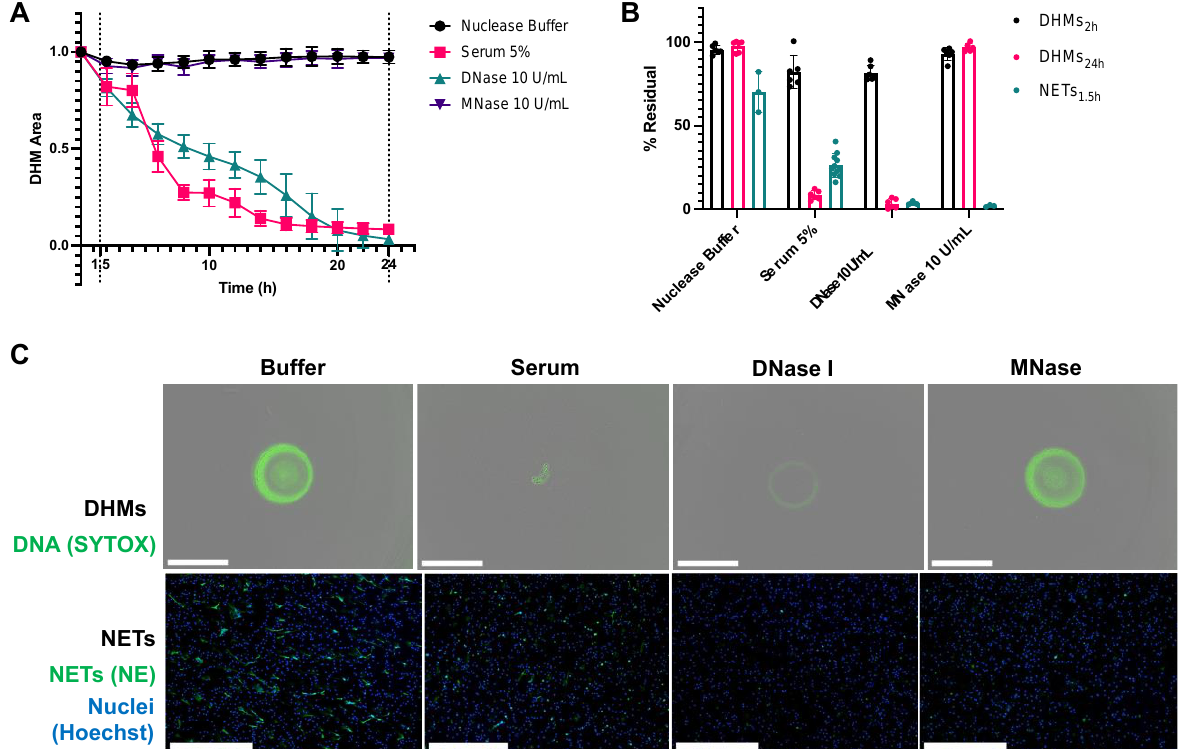
Figure 5. Differences are noted between cell-derived NETs and DHMs. ( A ) The kinetic curves of DHM degradation show that while NETs were degraded after a 1.5-h incubation, a time point marked with a dotted line, DHMs required a 24-h incubation for a comparable degradation extent. DHMs were degraded by serum and deoxyribonuclease I (DNase I), while buffer control and mi- crococcal nuclease (MNase) did not degrade DHMs. ( B ) DHMs degraded slowly when incubated with normal serum and nucleases relative to NETs. Residuals at time points for DHMs at 2 h show- ing minimal degradation, at 24 h showing the full extent of degradation, and for NETs, 1.5 h led to complete degradation. Readings for NET degradation were based on SYTOX Green signal. ( C ) Re- sidual DHM structures were visualized with fluorescent microscopy after a 24-h incubation period with various degradation conditions (top panel) and NETs after a 1.5-h incubation period (bottom panel). DHM structures were stained with SYTOX Green. NETs were stained with neutrophil elas- tase (green), and neutrophils stained with Hoechst stain (blue) for visualization purposes. The scale bar is 650 μ m. 2.6. DHMs Show Similarities to NETs with Regards to Degradation by SLE Serum We tested DHM degradation by serum samples from patients with systemic lupus erythematosus (SLE). DHMs pre-stained with 1 μ M SYTOX Green were incubated with degradation treatments for 12 h, and residual images were acquired with fluorescent mi- croscopy (Figure 6). Representative serum samples were selected to include normal con- trols, an SLE patient with low disease activity, and an SLE patient with high disease ac- tivity. The patient with high disease activity was known to have defective NET degrada- tion based on pilot experiments that were part of our prior work [7]. These serum samples were diluted to 5% in nuclease buffer and incubated with DHMs. DHMs structures were efficiently degraded by 5% control serum and 5% SLE serum (low disease activity). In contrast, significant residual DHMs remained when incubated with serum from the SLE patient with high disease activity. Although DHMs have a minimal chromatin backbone composition and show slower degradation than NETs, they were able to mimic NETs in being degraded to a greater extent by serum from normal control donors than lupus do- nors.